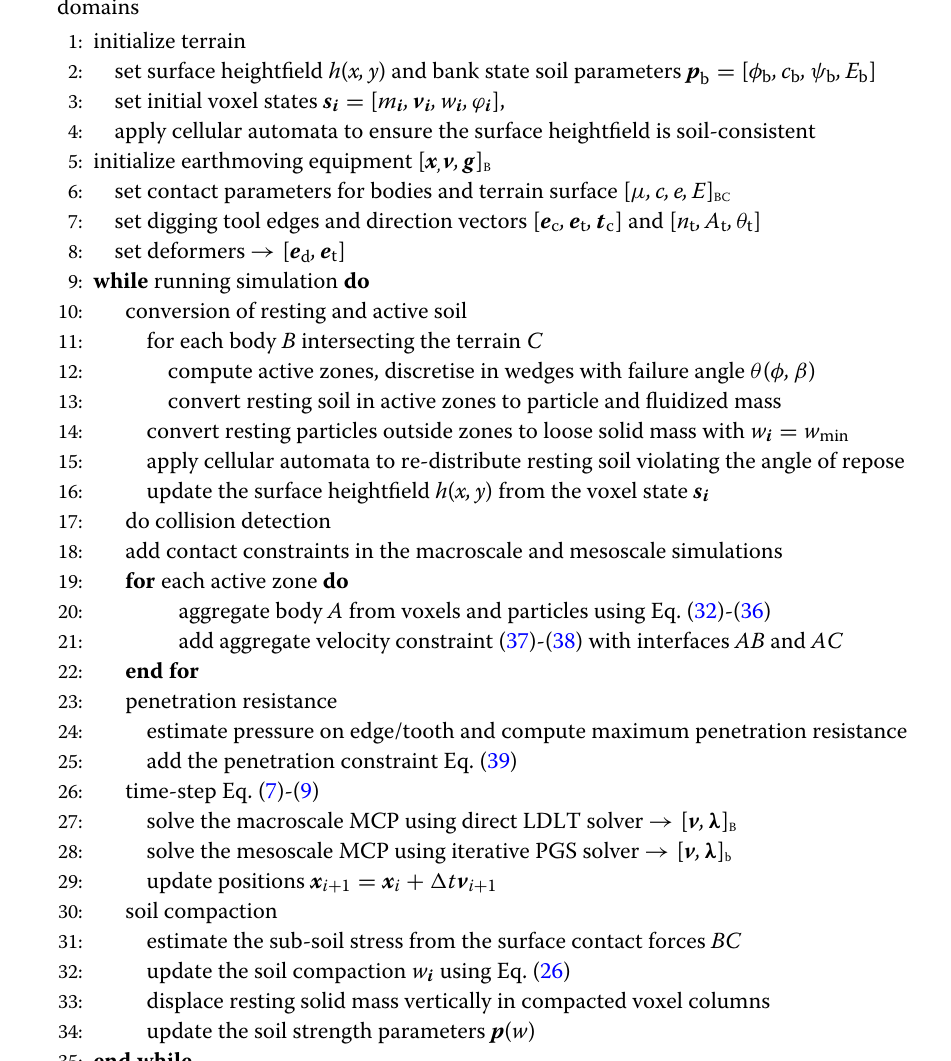
Algorithm 1 Multiscale terrain